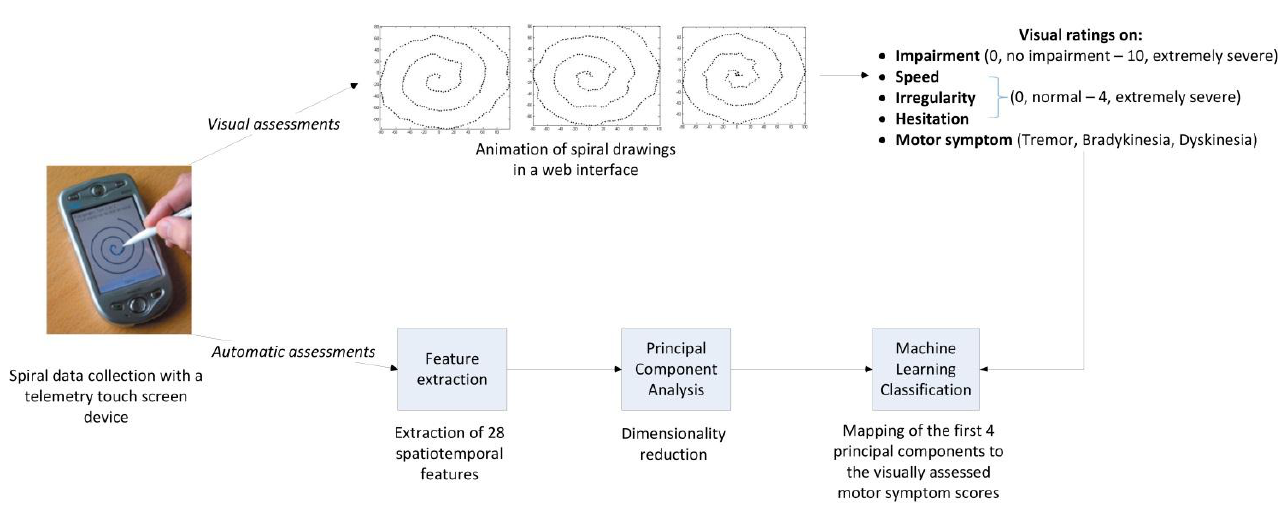
Figure 1. Schematic of the experimental